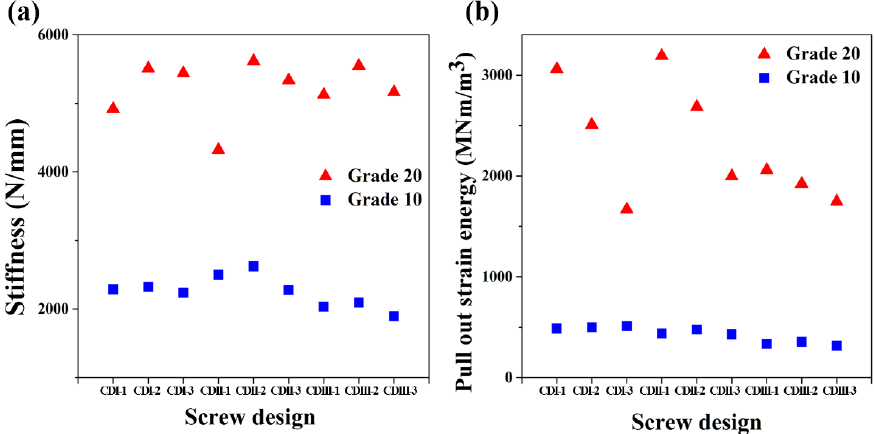
Figure 5. Schematic diagram of pullout behavior.